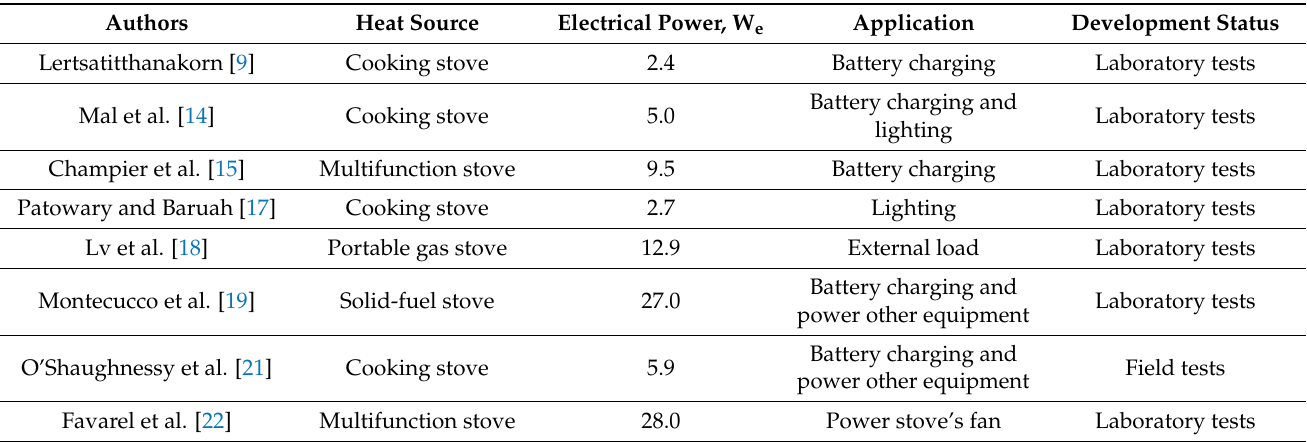
Table 1. The summary of selected previous research on TEGs integrated with